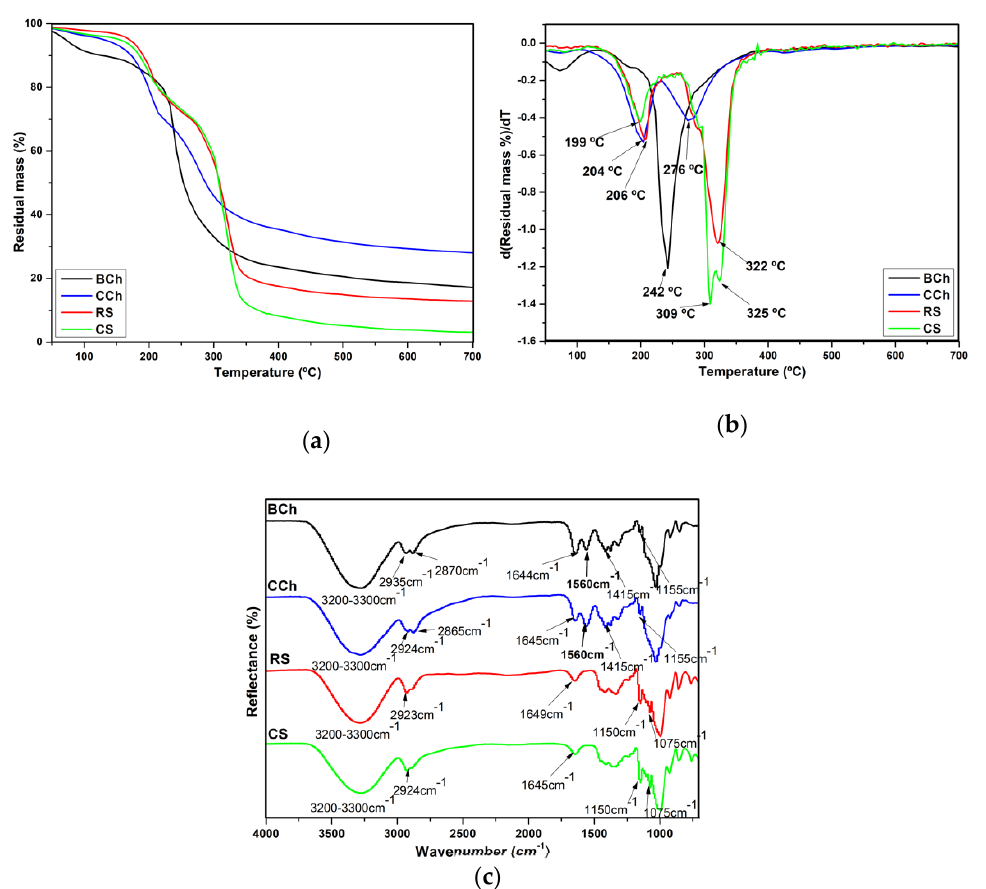
Figure 1. TGA ( a ) and DTGA ( b ) curves and ( c ) FTIR spectra for BCh, CCh, RS and CS films.